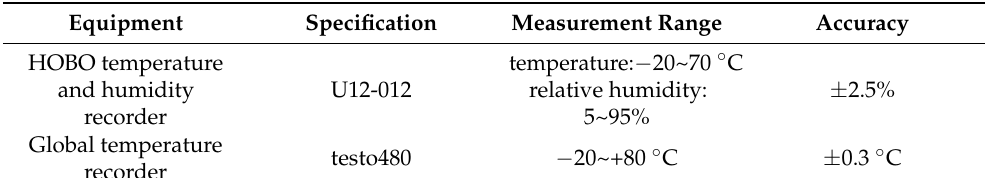
Table 1. The parameters of the measurement equipment used.